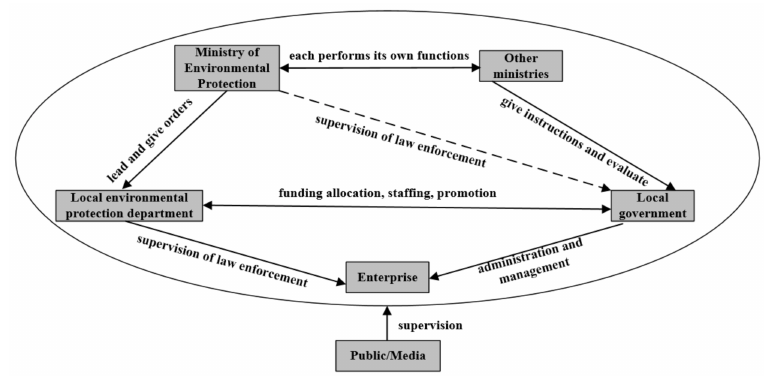
Figure 9. Environmental governance system.